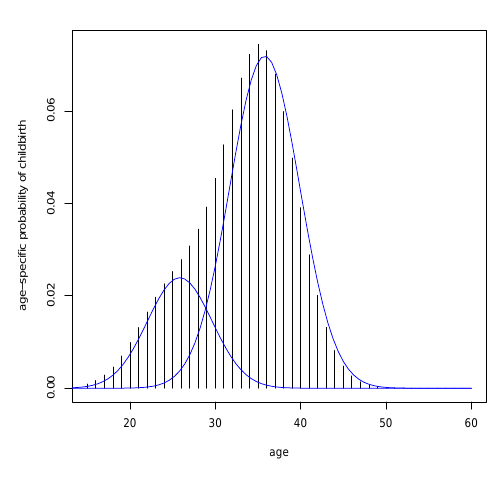
Figure 3 – Posterior mean probability mass function of area 6 with the two principal mixture